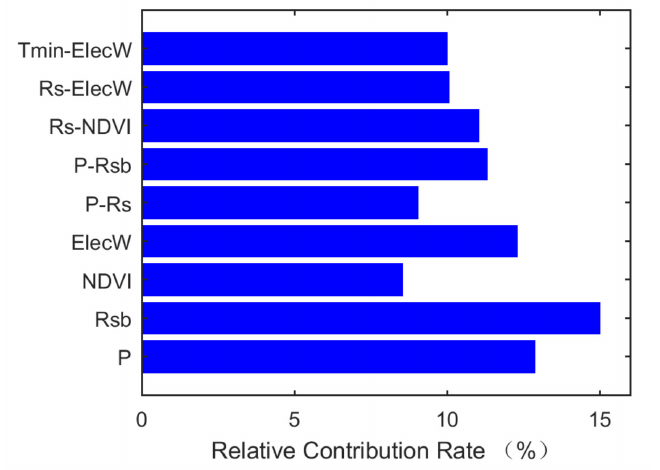
Figure 9. The relative importance of single variables and interacting variables in the final